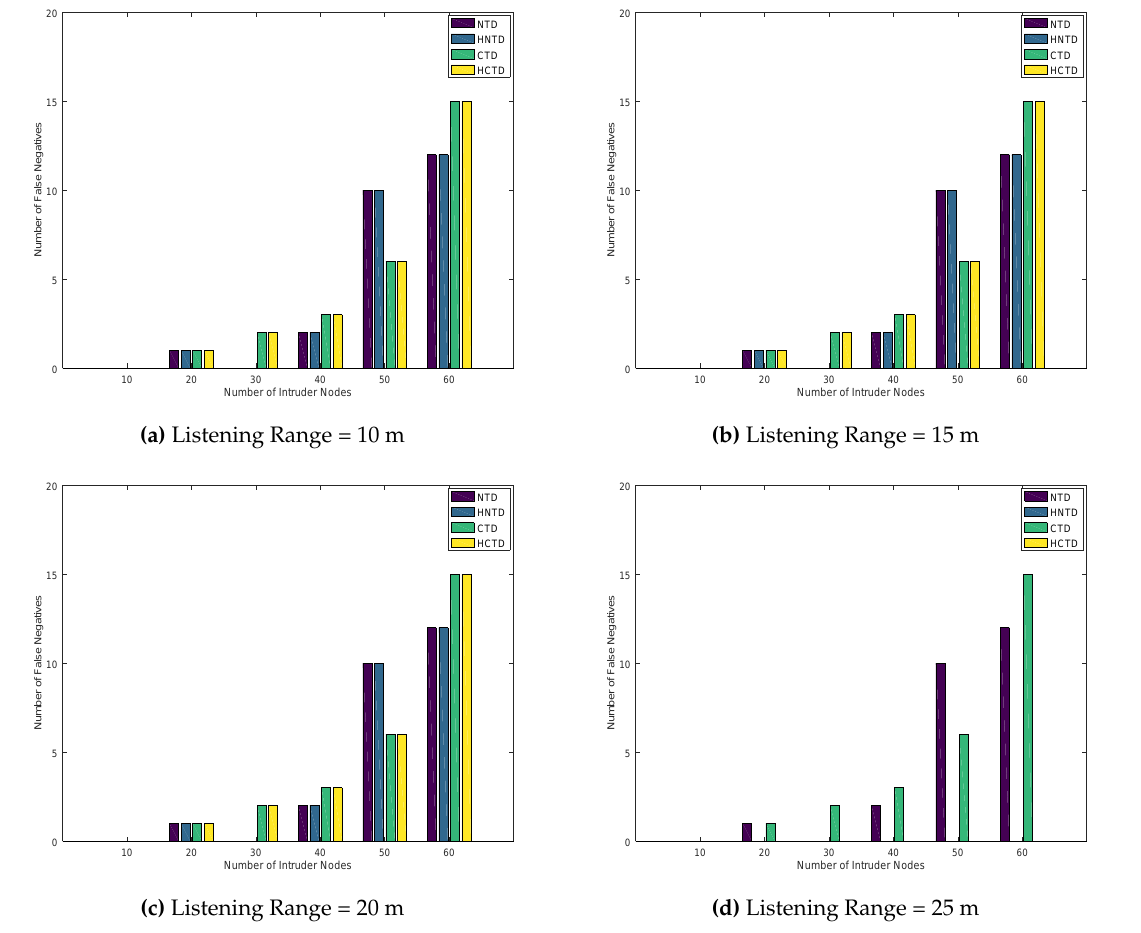
Figure 4. Number of False Negatives for Homogeneously placed